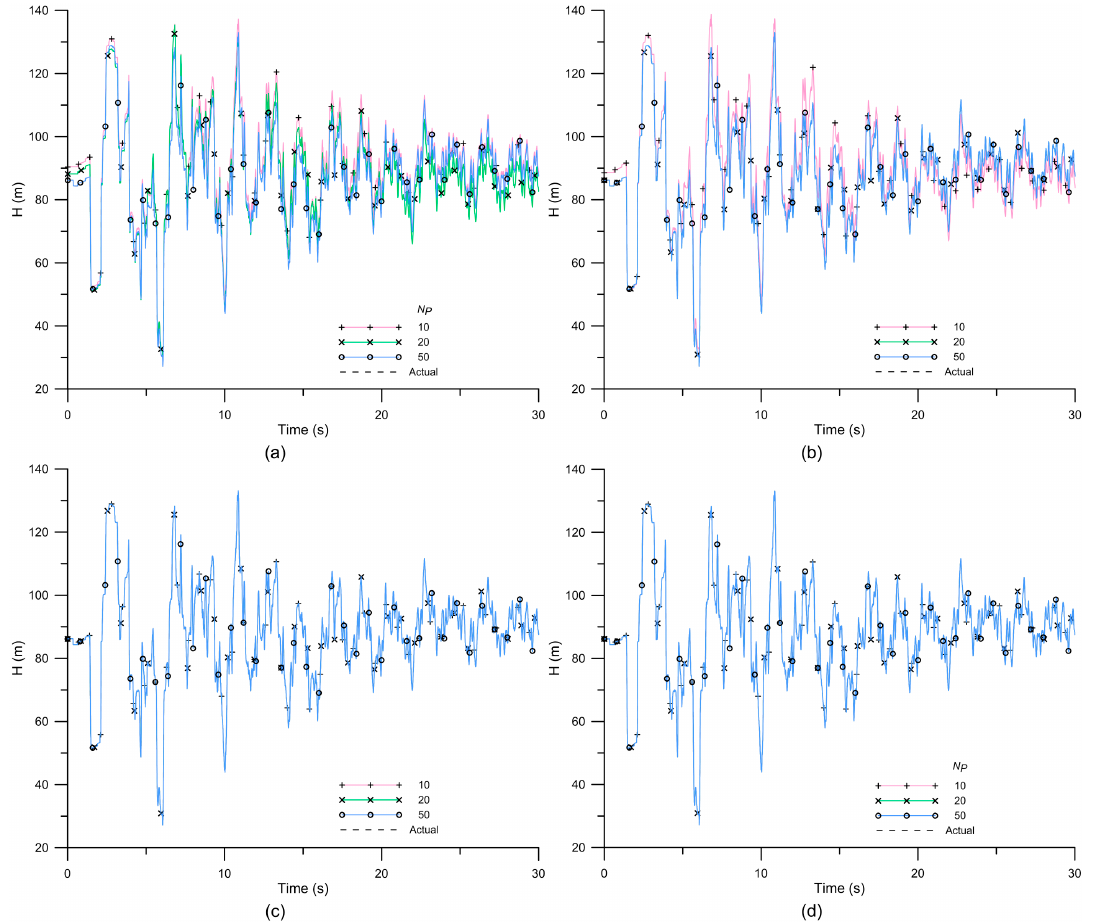
Figure 4. Temporal transient perturbations at N8 of pipe network A predicted by ( a ) PEGA, ( b ) PEPSO, ( c ) PESOS, and ( d ) PEOS with various N P .